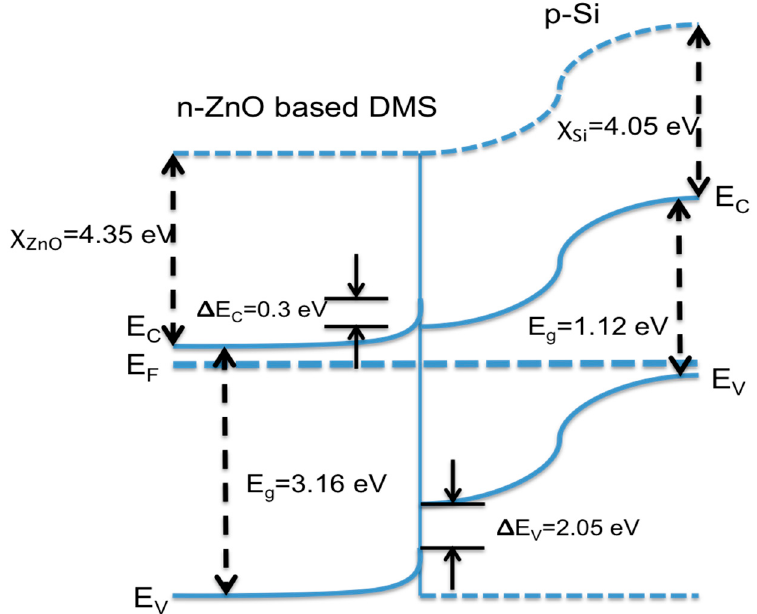
Figure 10. Energy band diagram for the n-ZnO-based DMS/p-Si heterojunction .